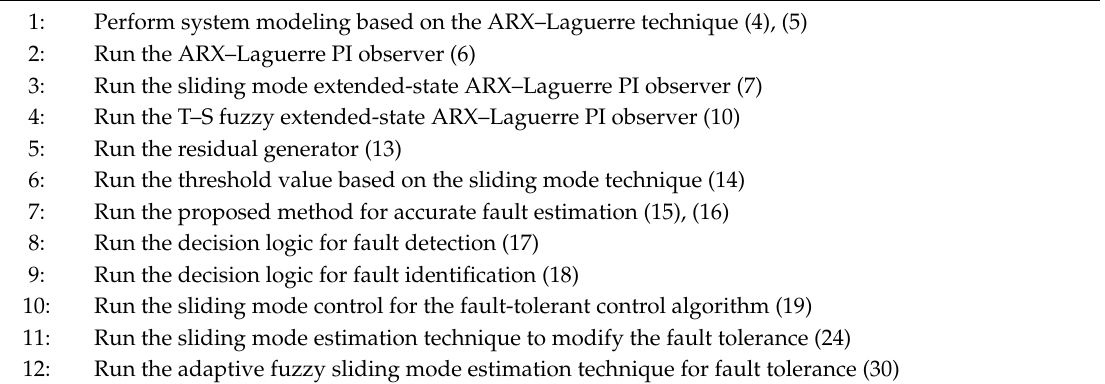
Algorithm 1. Adaptive T–S fuzzy sliding mode extended-state ARX–Laguerre PI observer for fault detection, estimation, identification, and tolerant control of a robot